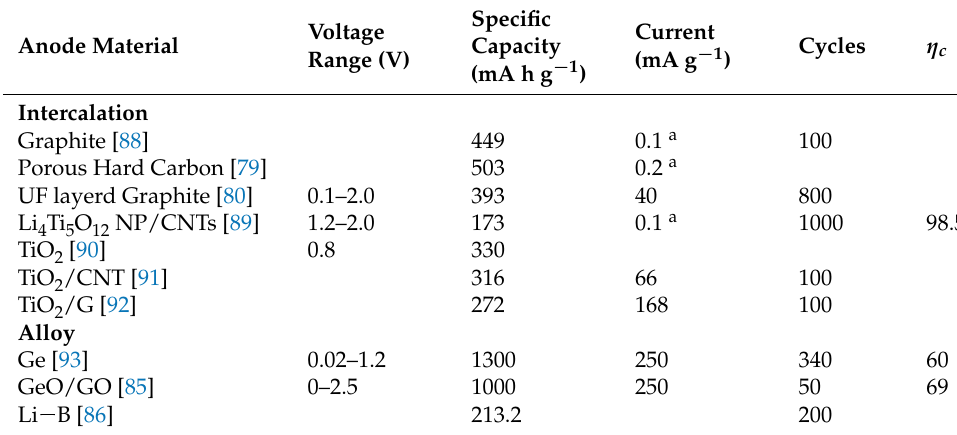
Table 2. Anode materials for Li-based